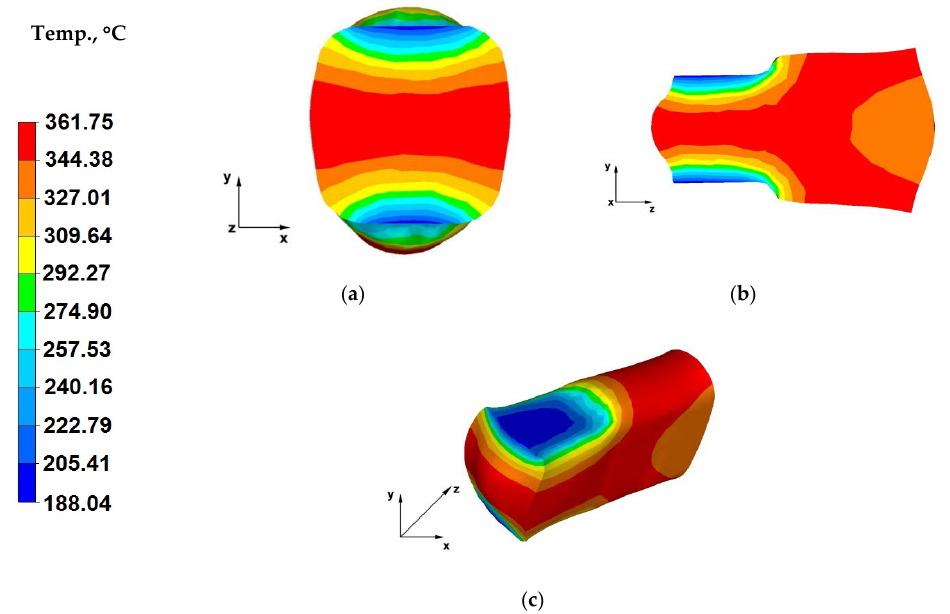
Figure 9. ( a ) Temperature distribution over the cross-section of an AZ91 alloy forging deformed within the fourth pass, with a relative reduction of 40%, in flat dies, after a 90° turning of the forging; ( b ) Temperature distribution over the longitudinal section of an AZ91 alloy forging deformed within the fourth pass, with a relative reduction of 40%, in flat dies, after a 90° turning of the forging; ( c ) Axonometric view of the temperature distribution over the surface of an AZ91 alloy forged within the fourth forging pass, with a relative reduction of 40%, in flat dies, after a 90° turning of the forging. Analysis of the data in Figure 10a indicates that in the case of the sixth pass, the cooling down of the metal areas within the contact zones with dies was lower and the forging temperature in these areas was 191 °C. Axial forging zones recorded a temperature drop of 53 °C, from the initial